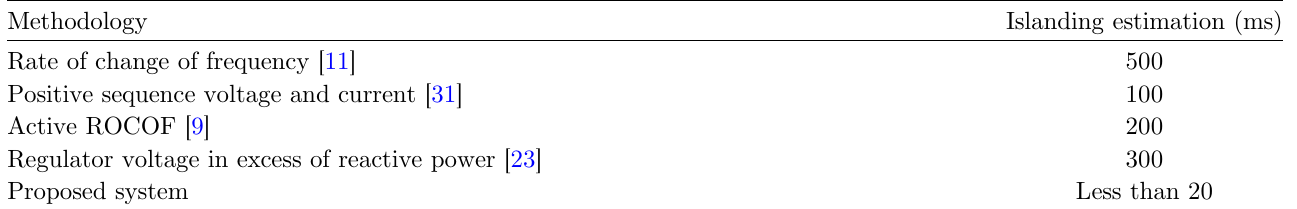
Table 2. Proposed strategy on existing techniques.